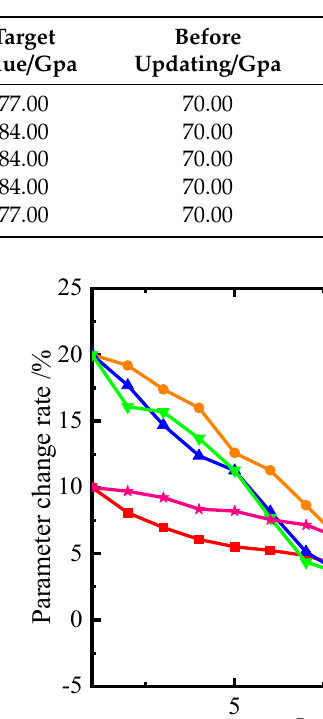
Table 4. Comparison of Parameters Before and After Model Updating Under 5% White Noise.